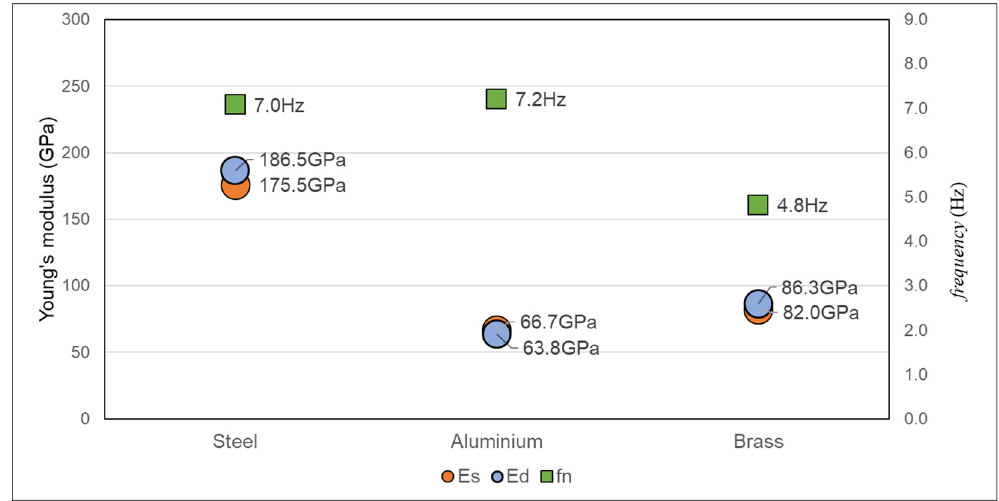
Figure 6. Summary of static and dynamic Young’s moduli and natural frequency of steel, aluminium and